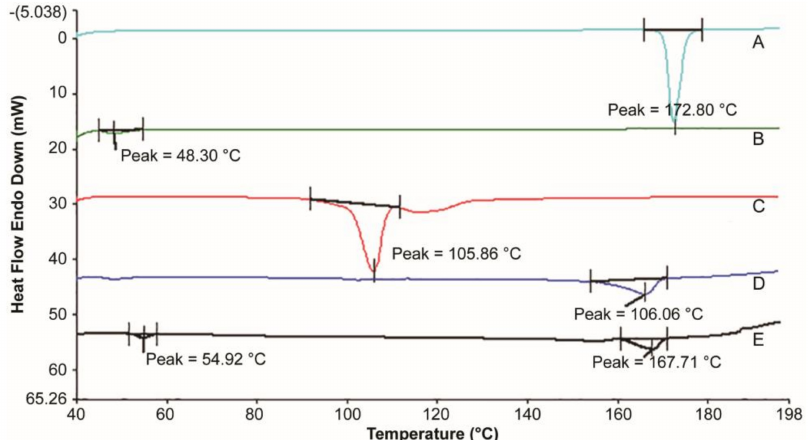
Figure 3. Thermal analysis diagram between risperidone and excipients. Thermal analysis curve. ( A ) Risperidone. ( B ) Polylactic acid. ( C ) Magnesium stearate. ( D ) The physical mixture of risperi- done/polylactic acid/magnesium stearate. ( E ) Risperidone